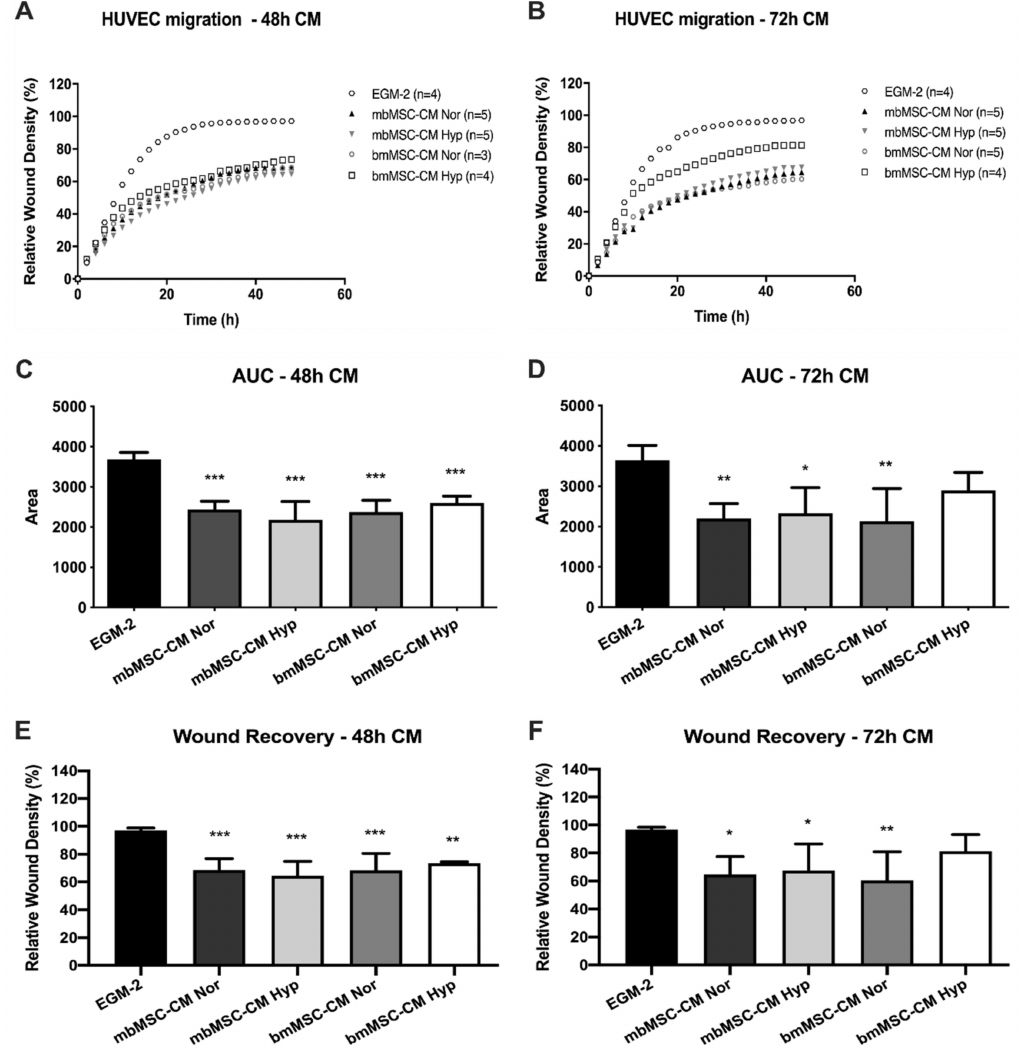
Figure 5. Impact of MSC conditioned medium over HUVEC EA.Hy926 migration by scratch wound assay in vitro. HUVEC migration curves in the presence of serum-free mbMSC and bmMSC-CM, obtained after ( A ) 48 and ( B ) 72-h of culture in normoxia and 1% hypoxia. Sample size for each condition are indicated. ( C , D ) Area under the curve (AUC) relative to HUVEC migration curves in the presence of 48 and 72 h-CM of mbMSC and bmMSC. ( E , F ) Wound recovery promoted by 48 and 72 h-CM of mbMSC and bmMSC at the point of 48 h after scratch. Values are expressed as mean ± SD; * p < 0.05; ** p < 0.01; *** p < 0.001 compared to EGM-2. CM, conditioned medium. Nor, normoxia. Hyp, hypoxia. EGM-2, endothelial growth medium